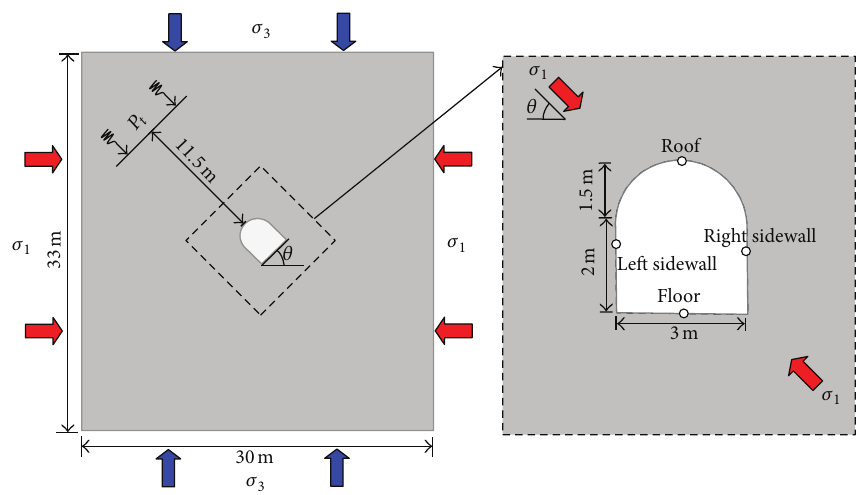
Figure 1: Numerical model with specific geometries and loading conditions.